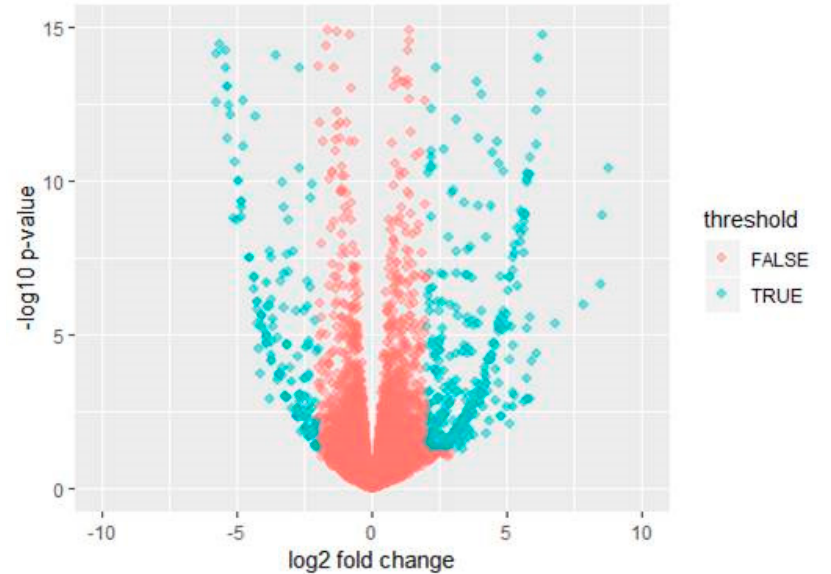
Figure 5. Expression changes of all genes. The volcano map displays expression changes of all genes. Blue represents differentially expressed genes (Log-fold change > 2.0 or Log-fold change < − 2.0, p -value < 0.05) between Normal and PsGAPDH transgenic samples.